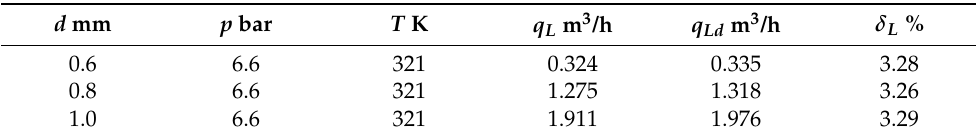
Table 2. The results of leakage flow measurements through the air nozzle with direct and indi- rect